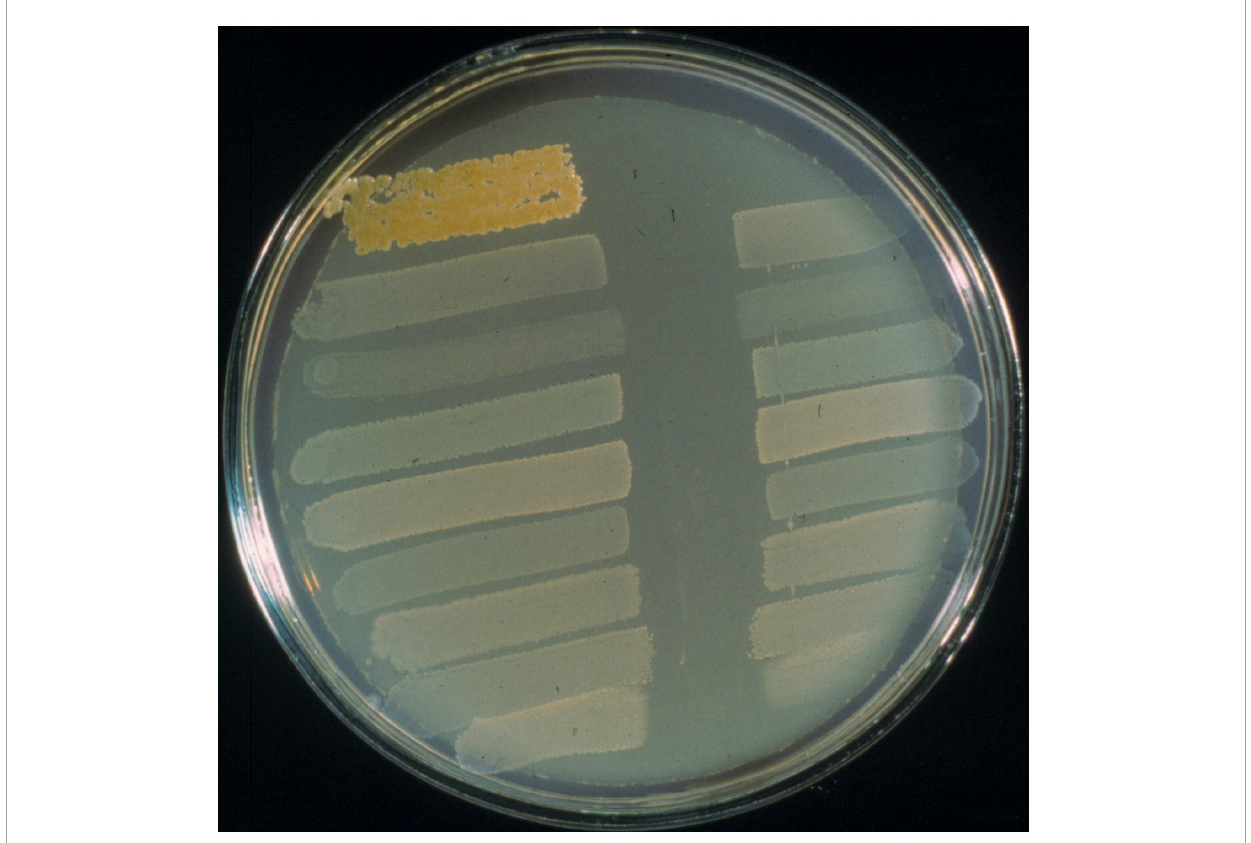
FIGURE5 BLIS “fingerprinting” assay of S. salivarius BLIS K12 using the deferred antagonism test methodology as described by Tagg and Bannister (1979). Interference with the growth of all nine standard indicators (as shown here) is referred to as BLIS P-type 777